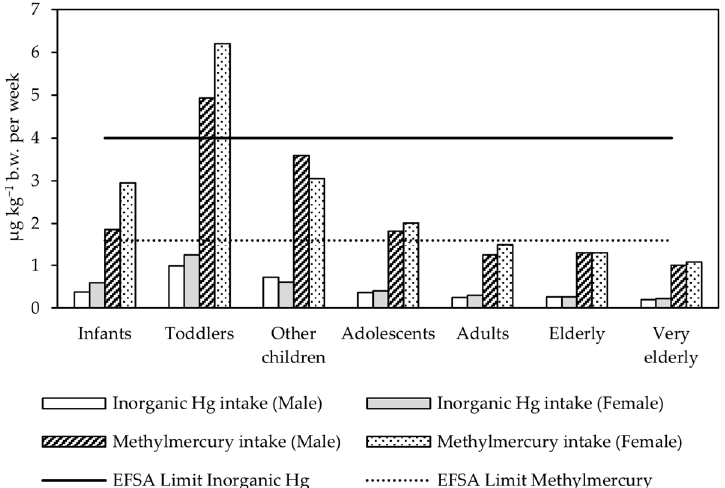
Figure 4. Intake of inorganic Hg and methylmercury ( µ g kg − 1 b.w. per week) from study samples as a function of gender and age of the Italian population. Individuals were categorized into seven age groups, covering infants (<1 year), toddlers (1 ≤ 3 years), other children (3 ≤ 10 years), adolescents (10 ≤ 18 years), adults (18 ≤ 65 years), the elderly (65 ≤ 75 years), and the very elderly ( ≥ 75 years).